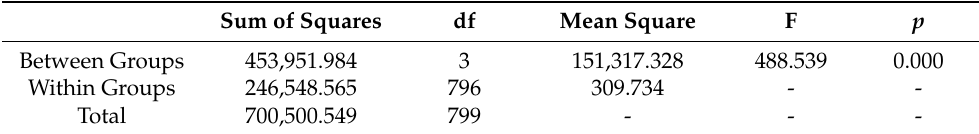
Table 2. One-way ANOVA results of nanoporosities for the TNTs anodized at 1, 2, 3 and 4 h.